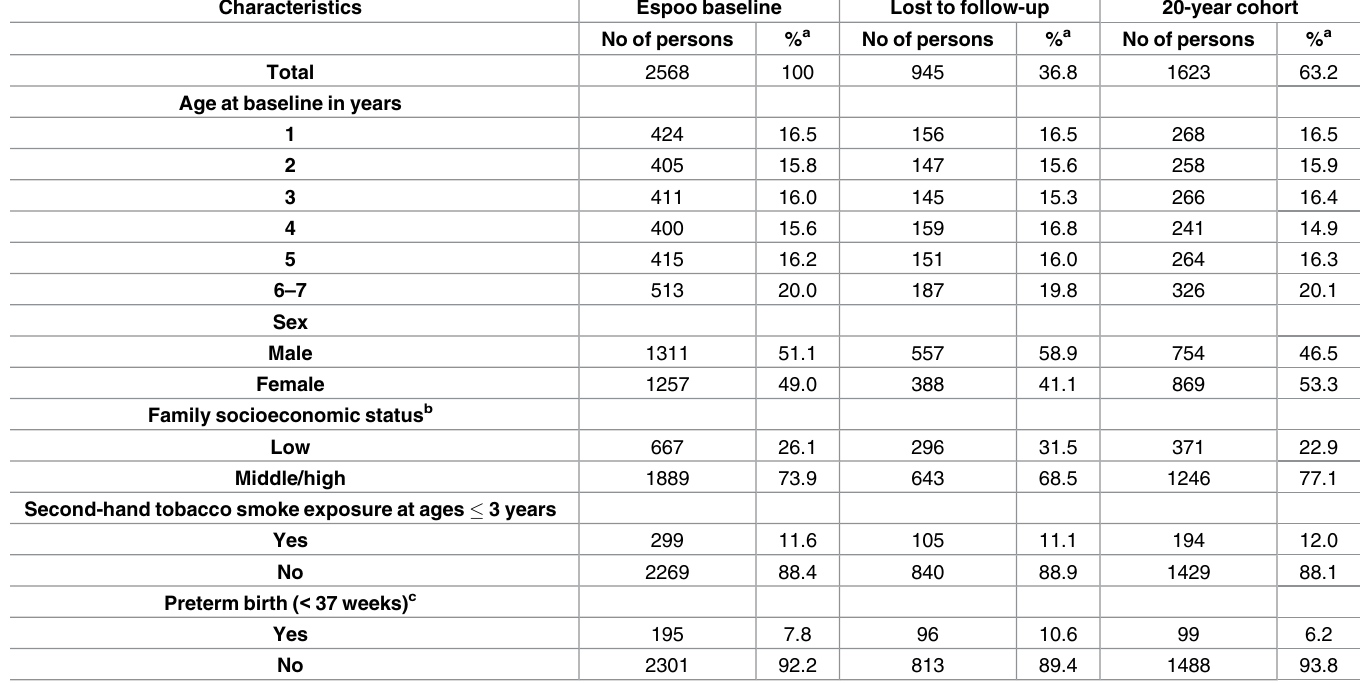
Table 2. Personal and environmental characteristics of the baseline population, subjects lost to follow-up, and the study population of 20-year cohort study, The Espoo Cohort Study 1991–2011.